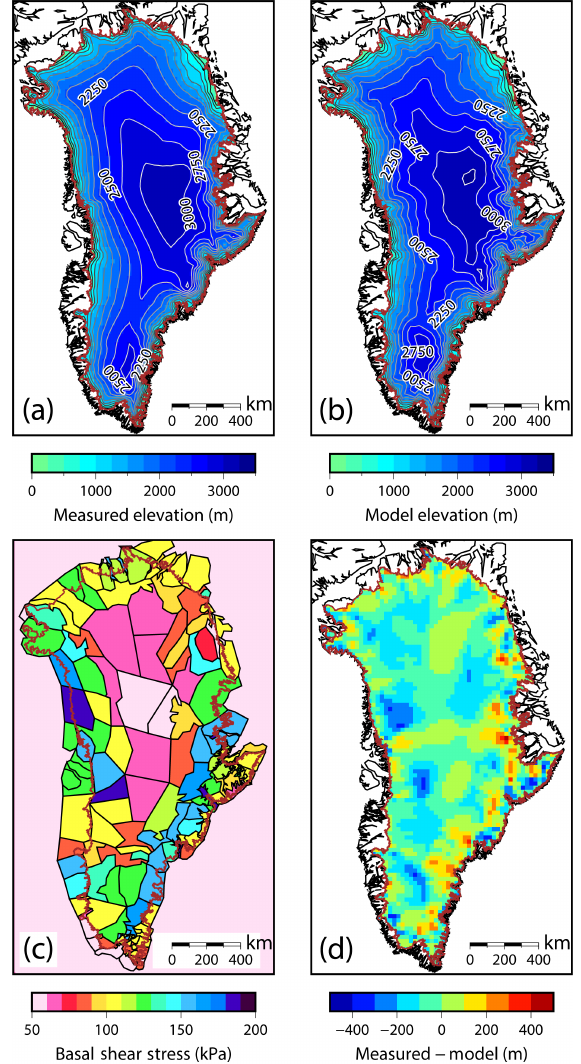
Figure 6. Sample reconstruction of the contemporary Greenland Ice Sheet. (a) Modern topography. The brown line is the current grounded ice margin, the black lines are the modern day coastlines. (b) Reconstructed topography. (c) Final iterated basal shear stress domains and values used for the reconstruction. (d) Difference be- tween the observed topography and reconstructed